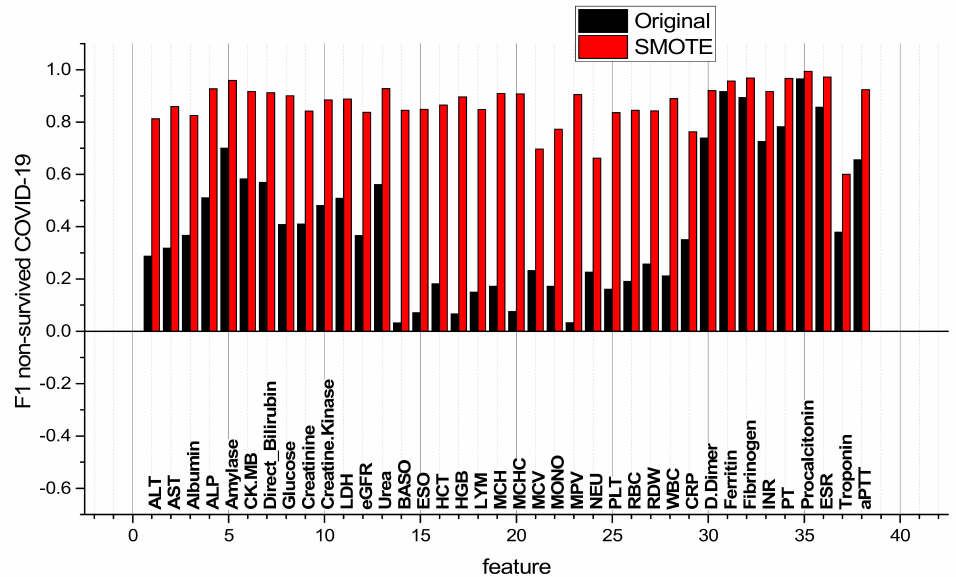
Figure 5. F1 metric for non-survived-COVID-19 class, calculated for original and SMOTE-balanced